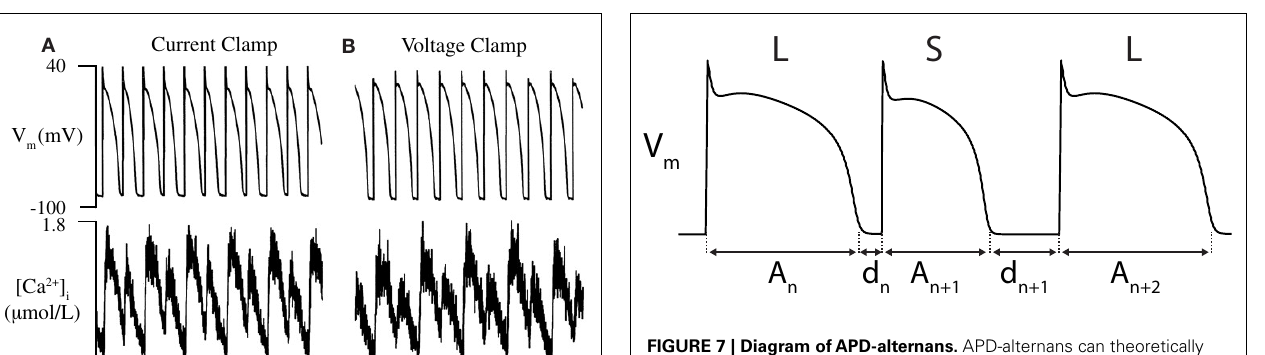
FIGURE 7 | Diagram ofAPD-alternans. APD-alternans can theoretically occur due to APD restitution alone (V m -driven alternans). See text for